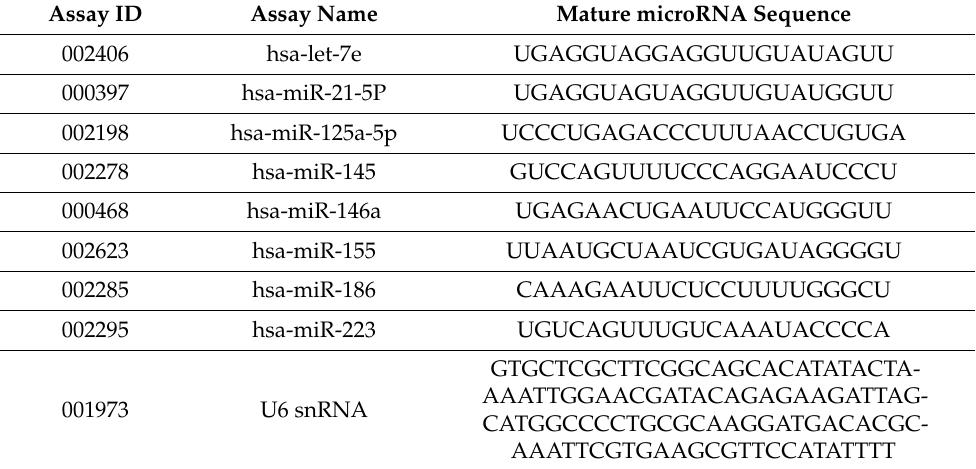
Table 1. Primers for